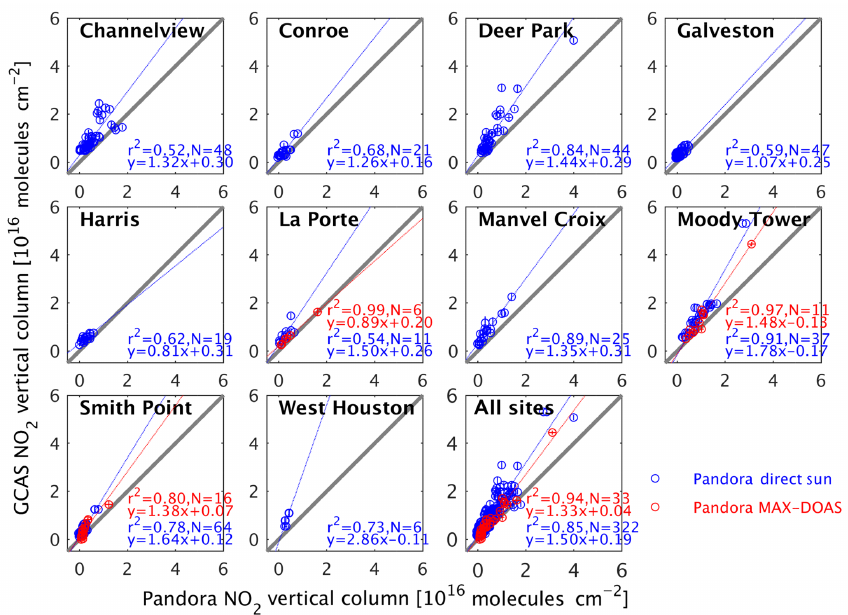
Figure 9. Pandora NO 2 tropospheric columns from direct-sun and MAX-DOAS observations vs. GCAS NO 2 tropospheric columns by site for cloud-free observations over Houston during DISCOVER-AQ Texas 2013. The Pandora direct-sun columns are the total NO 2 columns measured by Pandora minus the colocated modeled stratospheric NO 2 columns used in the GCAS analysis. The solid line represents the 1:1 ratio. The dotted lines represent the reduced major axis linear